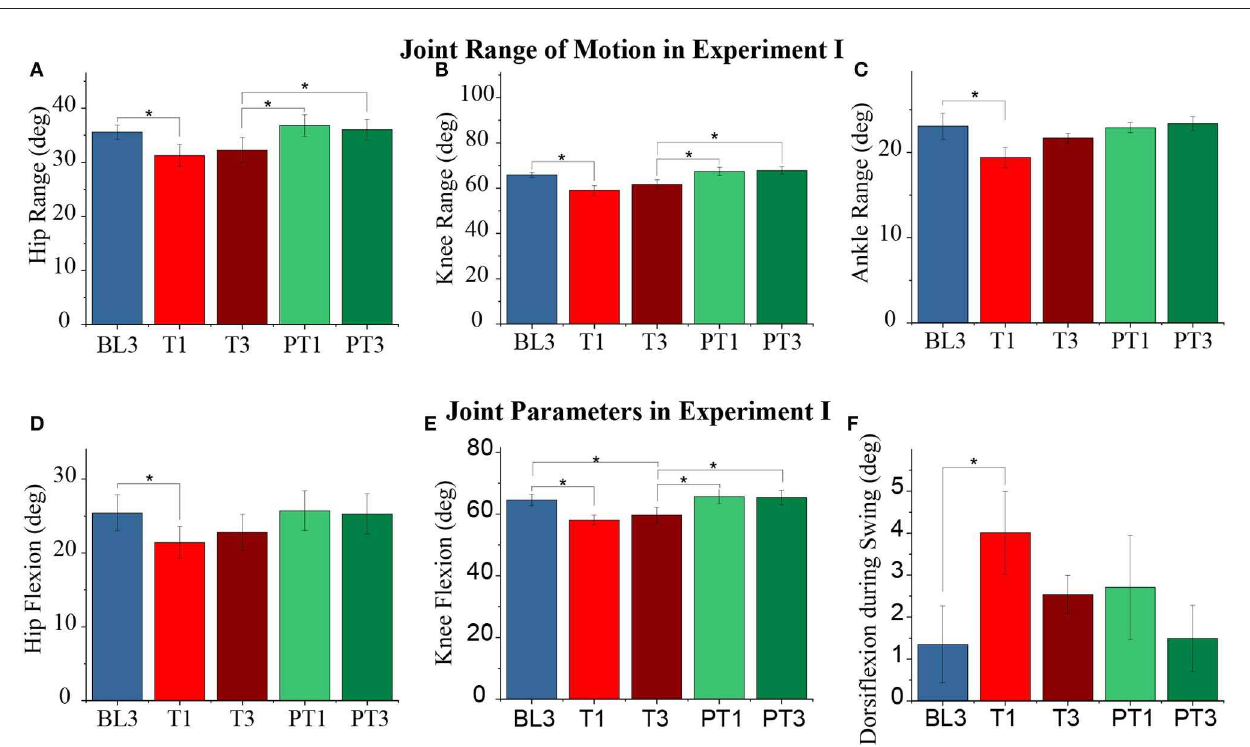
FIGURE 6 | (A–C) Range of motion of the perturbed leg’s hip, knee, and ankle joints, respectively, for different sessions. (D–F) Perturbed leg’s peak hip flexion, knee flexion, and ankle dorsiflexion during the swing over sessions, respectively. The data presented here is averaged across all participants of Experiment I with standard error (* p ≤